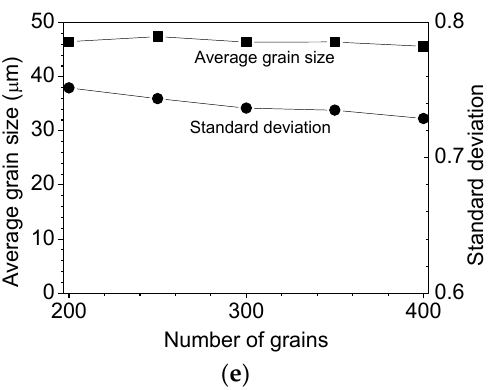
Figure 2. Histogram of austenite grain size in terms of the measured number of grains: ( a ) 200, ( b ) 250, ( c ) 300, and ( d ) 400. ( e ) is the average grain size and standard deviation as a function of the measured number of grains.